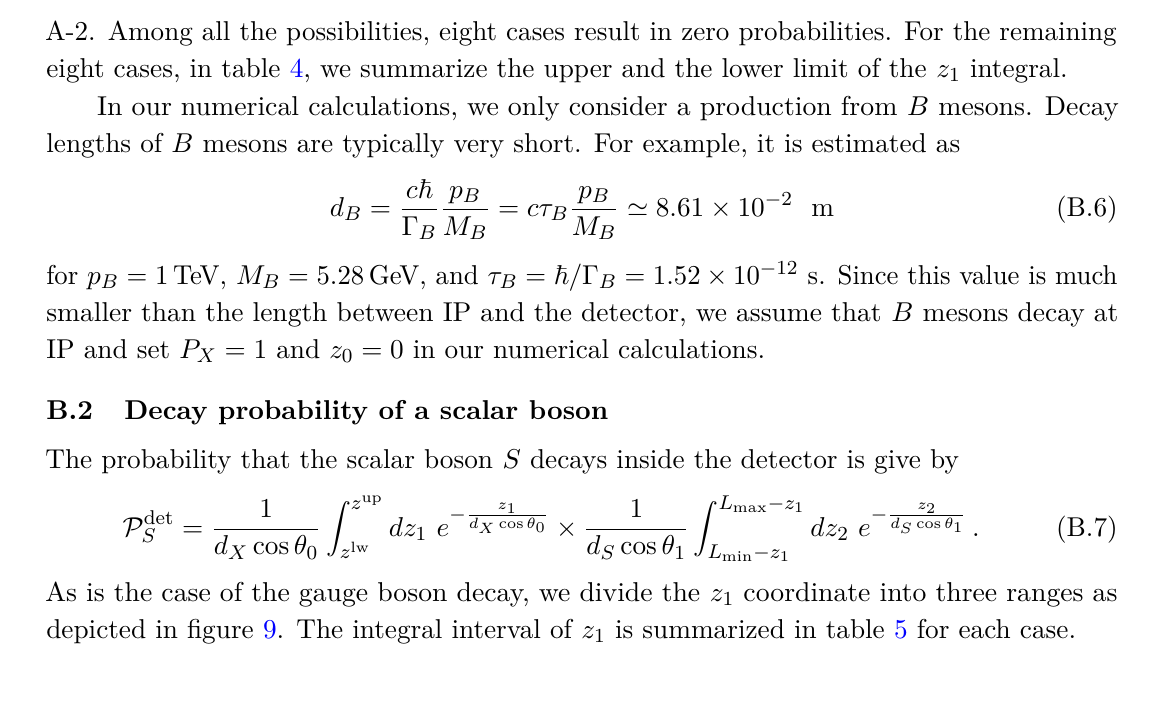
Table 4 . A summary of the integration interval of z 1 , where z ± probabilities are zero for the other